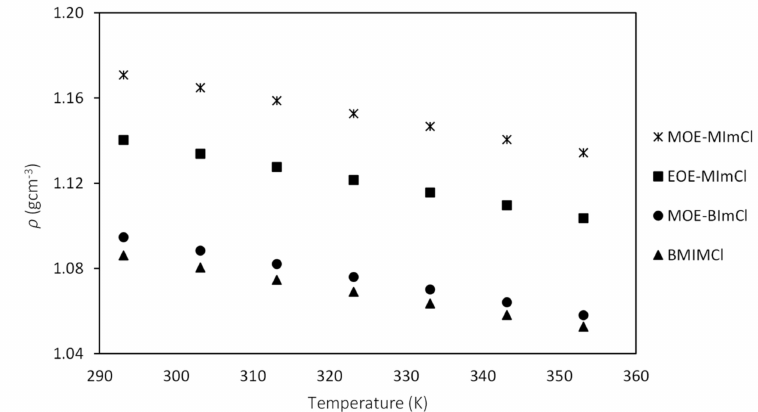
Figure 2. Density of